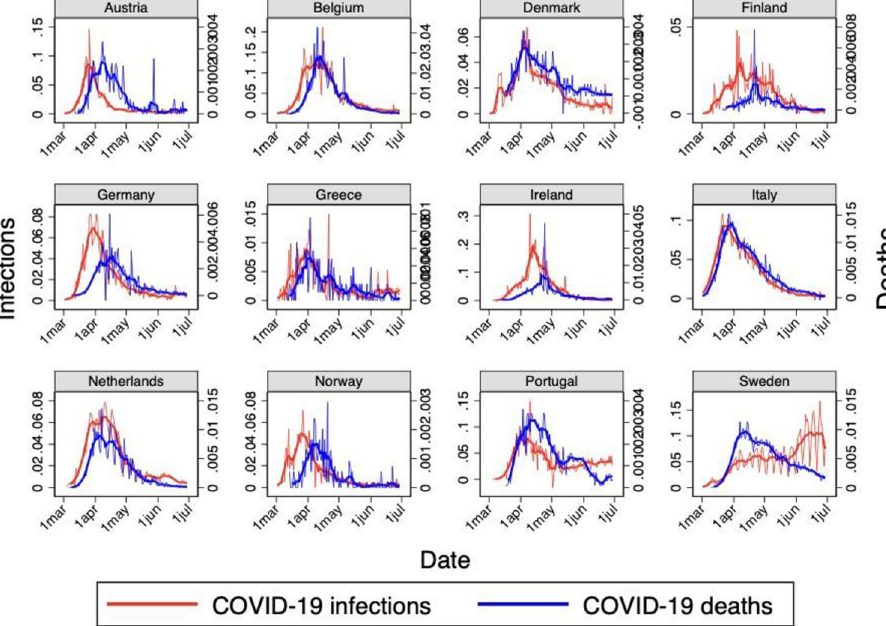
Fig 3. Recorded daily COVID-19 infections and deaths. Notes : The figure shows the number of daily COVID-19 infections and deaths per 1,000 inhabitants. The thinner profiles are the original daily series, while the thicker profiles are the smoothed series obtained by taking 7-day moving averages. Data source: Our World in